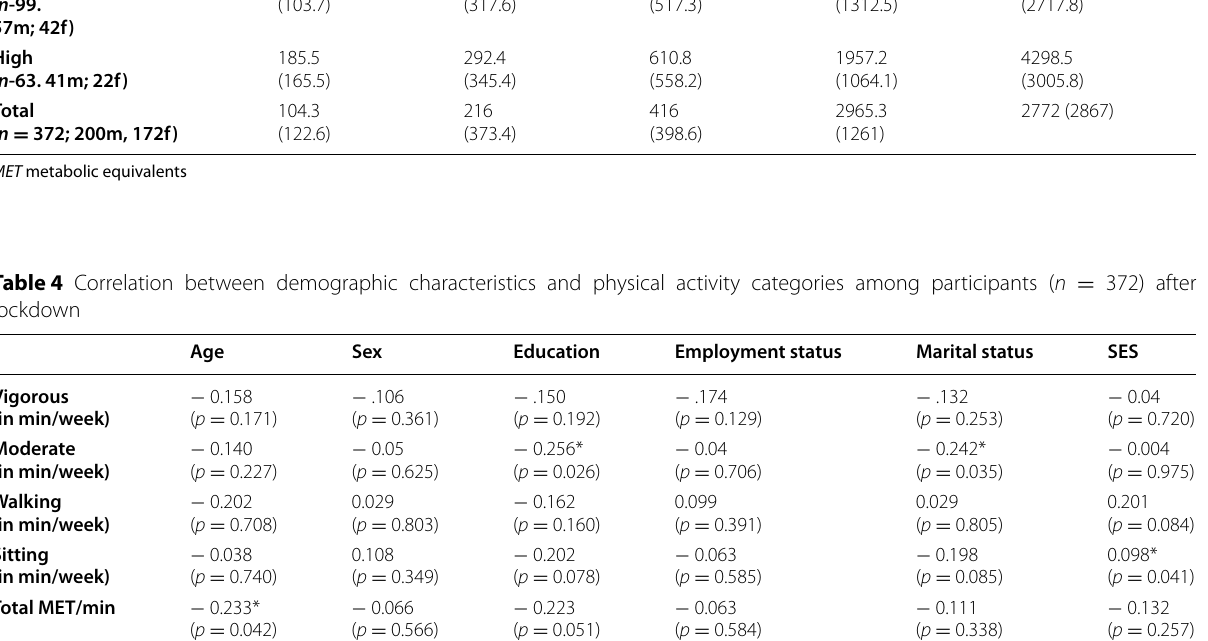
Table 3 Physical activity and sitting time of participants following introduction of lockdown measures classified on the basis of IPAQ-SF between categories